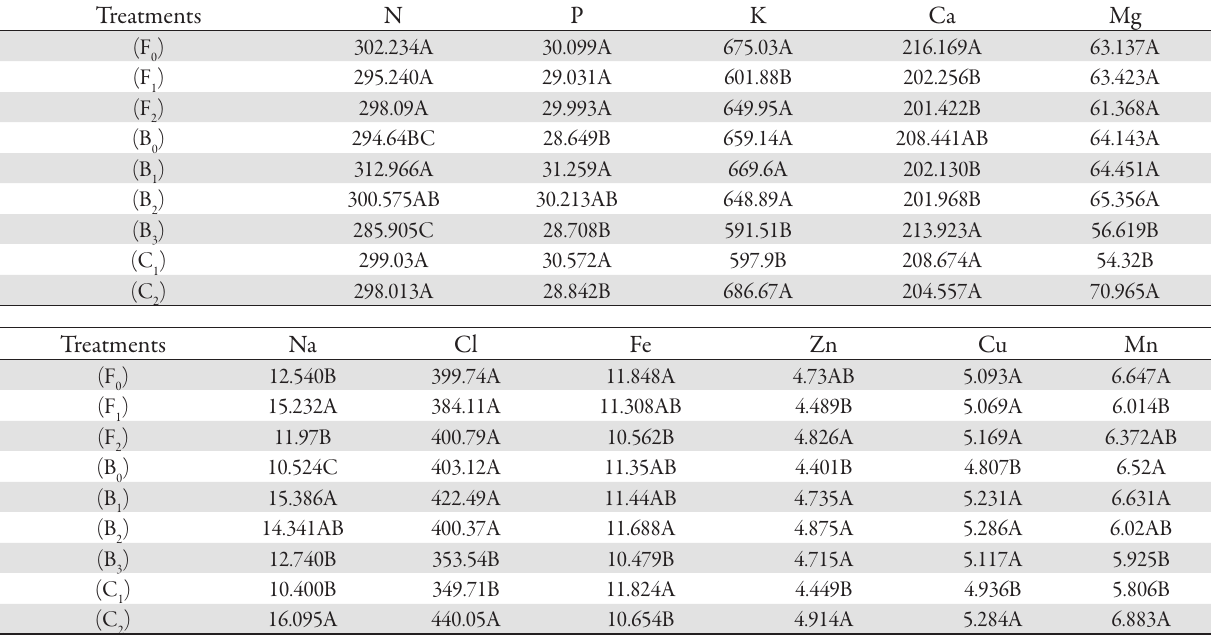
Tab. 4. The comparison of mean for the major effect of different levels of fungus, bacterium and cultivar on uptake of macro and micro elements and elements of Na and Cl (mg pot -1